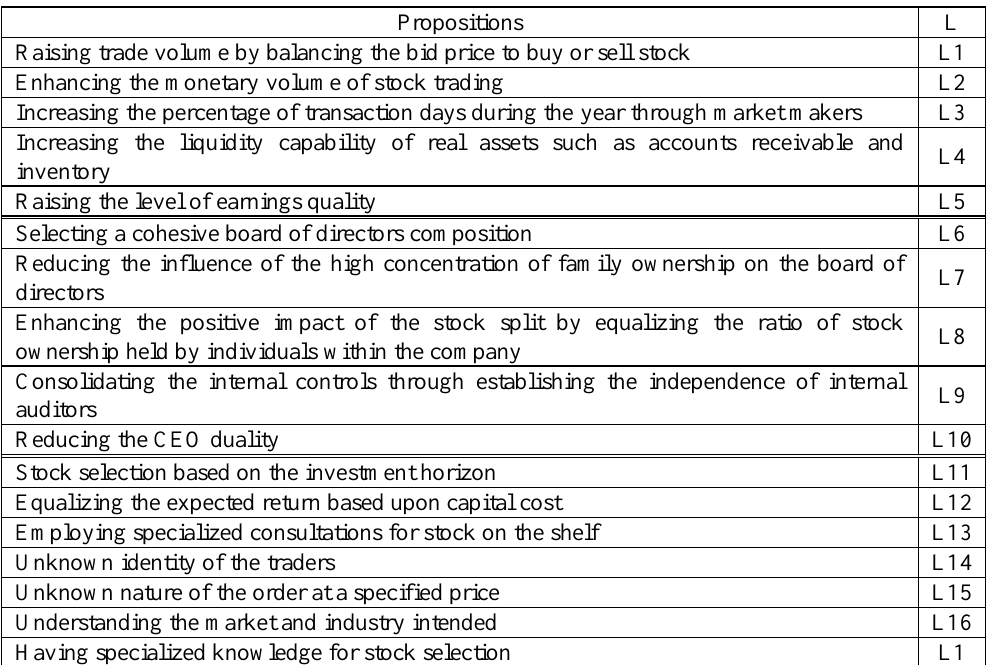
Table 7. Determining the abbreviated codes for matrix analysis